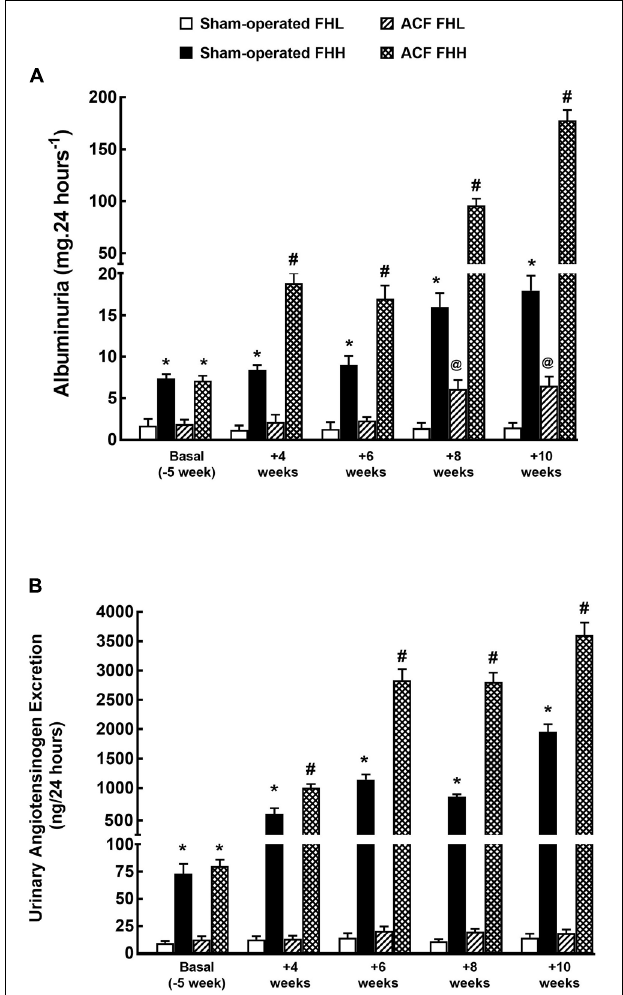
FIGURE 2 | Albuminuria (A) and urinary angiotensinogen excretion (B) in sham-operated FHL, FHH rats and in FHL and FHH rats with ACF. ∗ P < 0.05 for sham-operated FHH rats compared with sham-operated FHL rats at the same time point. # P < 0.05 for ACF FFH rats compared with sham-operated FHH rats at the same time point. @ P < 0.05 ACF FHL for rats compared with sham-operated FHL rats at the same time point.